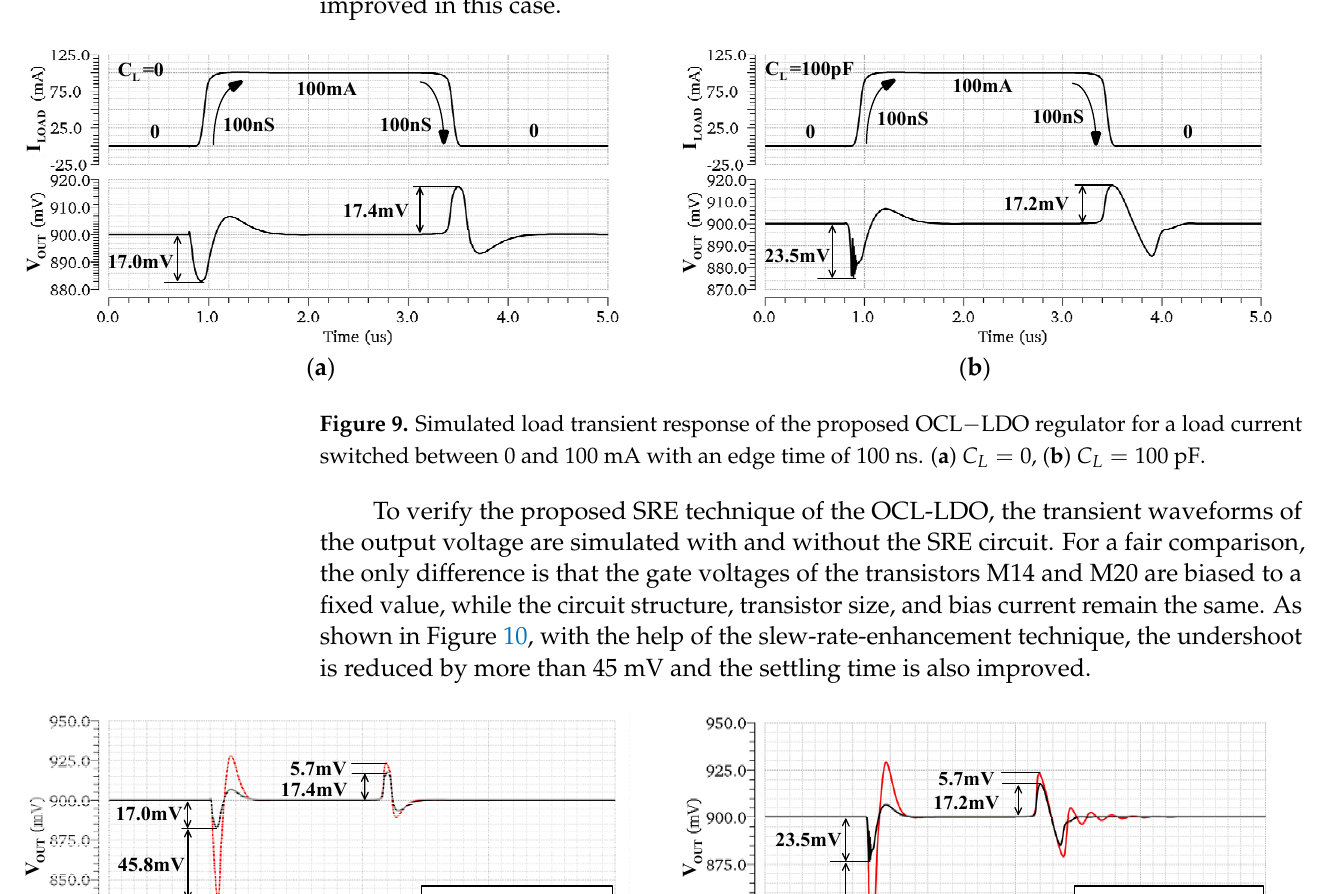
Figure 10. Simulated load transient response of the proposed OCL − LDO regulator under the cases with and without the SRE, for load currents switched between 0 and 100 mA with an edge time of 100 ns . ( a ) 𝐶 (cid:3013) = 0 , ( b ) 𝐶 (cid:3013) = 100 pF .